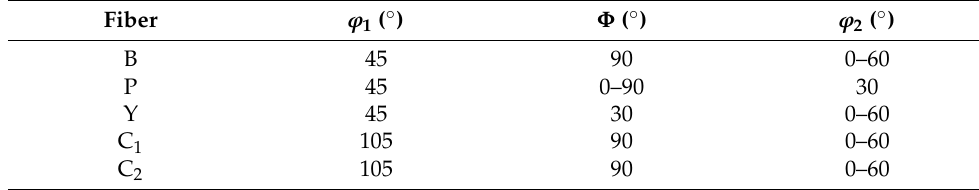
Figure 7. Texture evolution in {0002} pole Figures and IPF based on XRD: ( a , d ) 1P, ( b , e ) 4P and ( c , f ) 12P. Table 3. Ideal orientations for Mg alloy during ECAP with die angle of 90 ◦ [52]. Reprinted with permission from Ref. [52]. 2008;